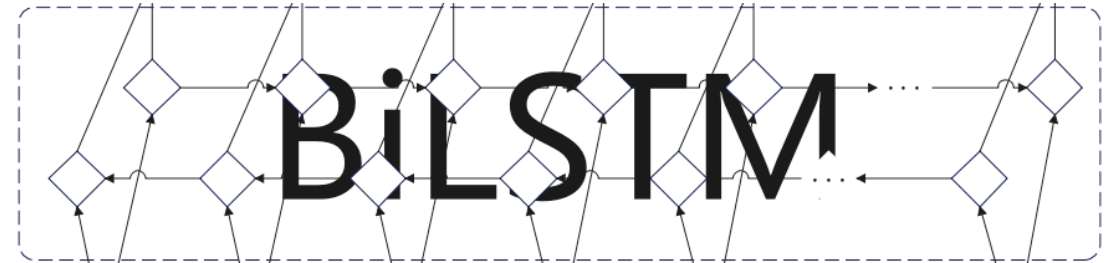
Figure 5. LSTM cell structure